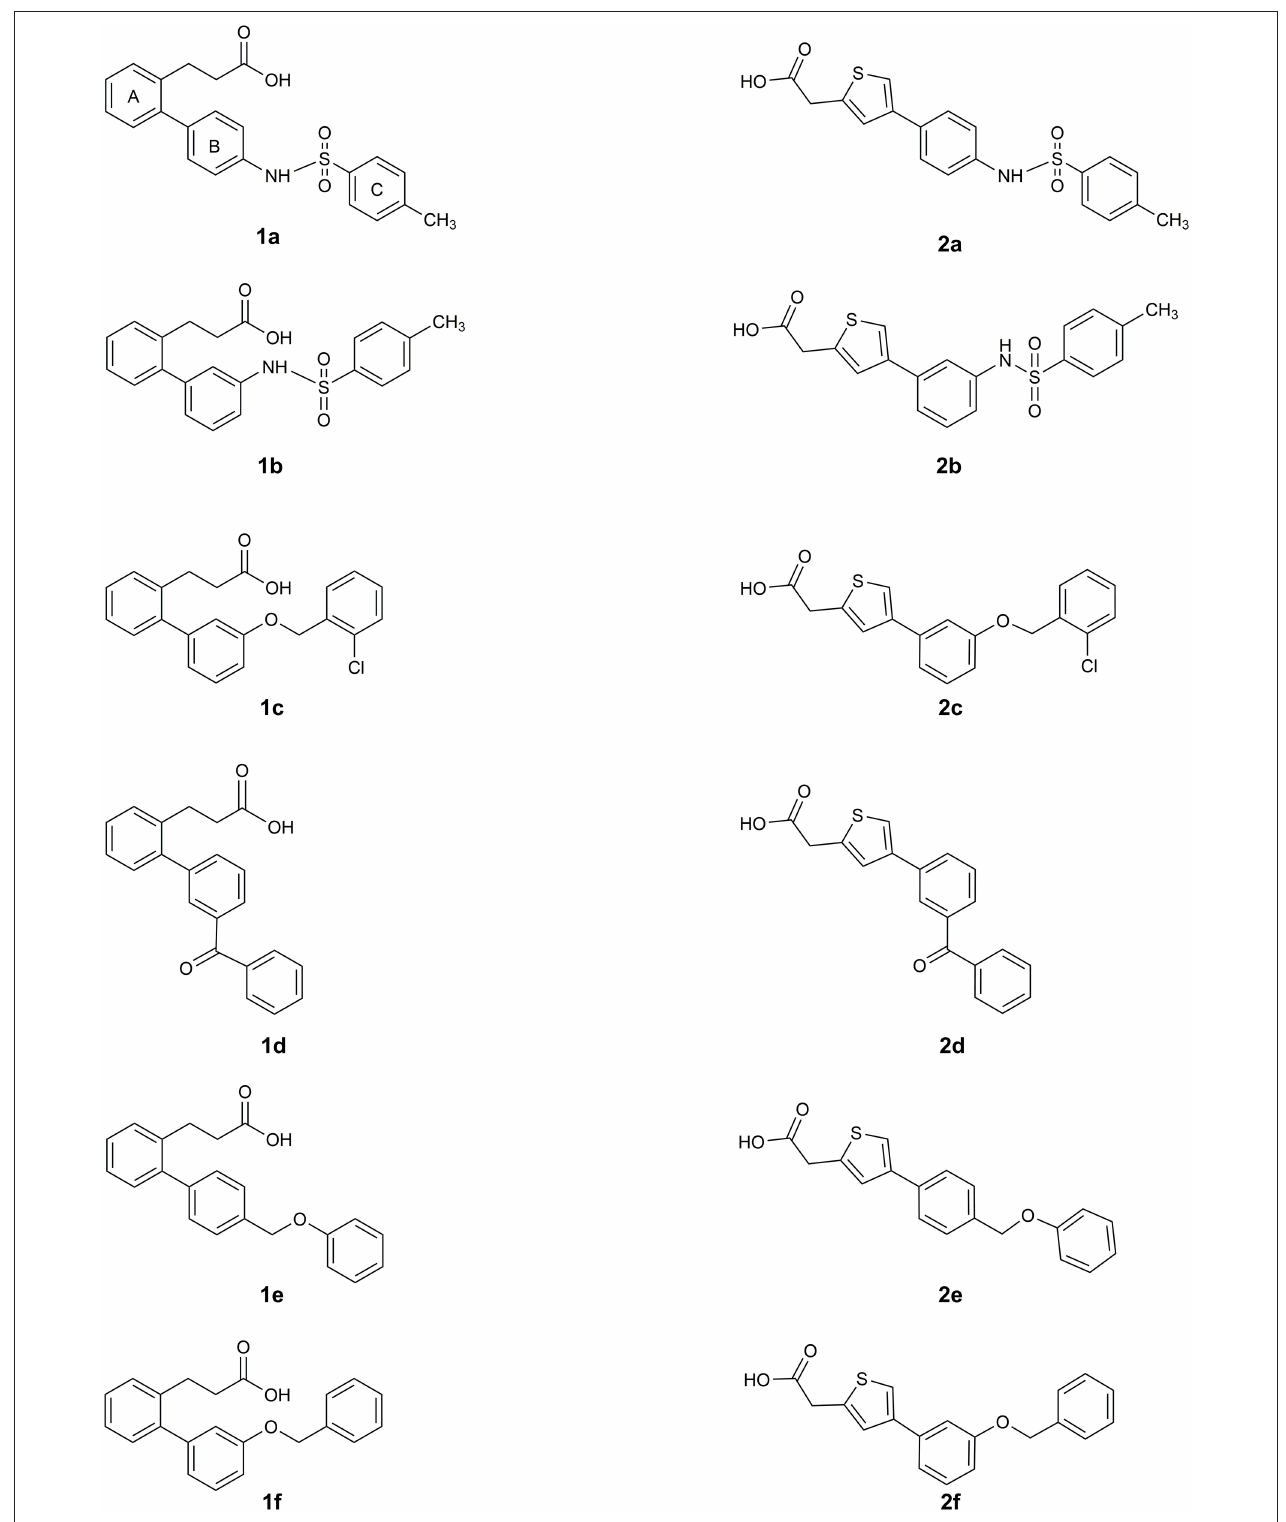
FIGURE 3 | Molecular structure of compounds 1a-f and 2a-f .